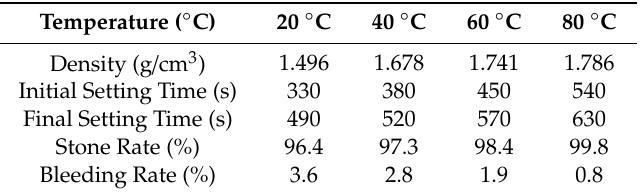
Table 3. The density, setting time, stone rate and bleeding rate of the HGTGS in di ff erent temperature conditions.